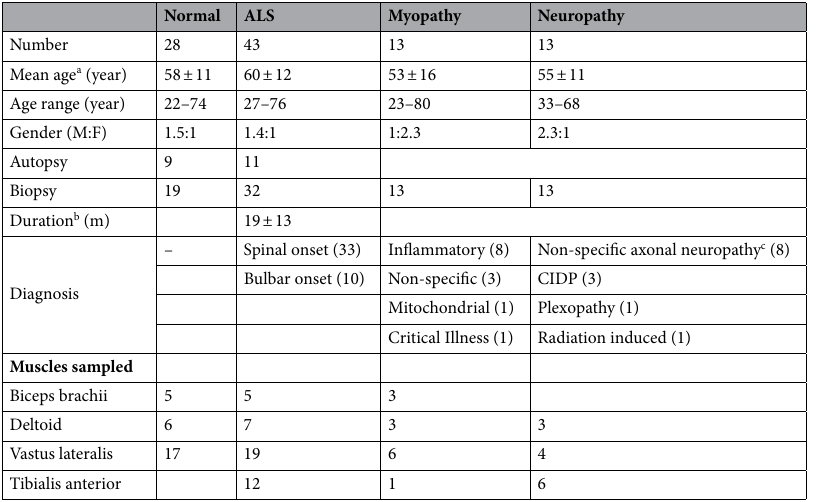
Table 1. Demographic and clinical data. CIDP chronic inflammatory demyelinating polyradiculoneuropathy, SD standard deviation. a Mean age (± SD) at time of sample collection. b Mean duration (± SD) of disease from onset of symptoms to time of sample collection. Duration of disease was unknown in two patients. c No patients were diagnosed with Charcot Marie Tooth